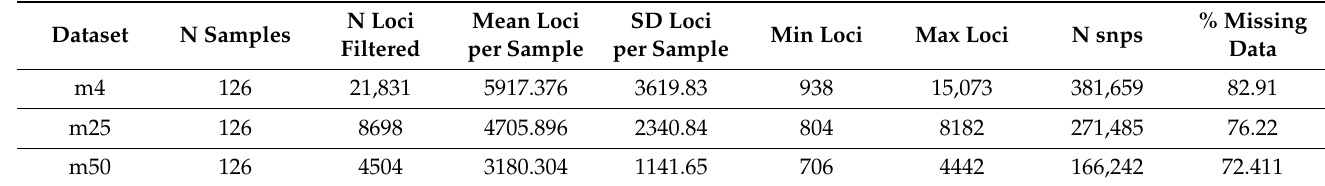
Table 2. Main summary statistics yielded by the three datasets generated by ipyrad from the three values of minimum taxon coverage tested. The three values aimed to represent (1) the default value, m = 4; (2) 25% of the total samples, m = 32; and (3) 50% of the total samples, m = 65, denoted as m4, m25, and m50, respectively. The main statistics provided are (1) number of loci filtered, (2) mean loci per sample, (3) standard deviation (SD) of number of loci per sample, (4) minimum number of loci per sample, (5) maximum number of loci per sample, (6) number of single nucleotide polymorphisms (N snps), and (6) percentage of missing data in the loci